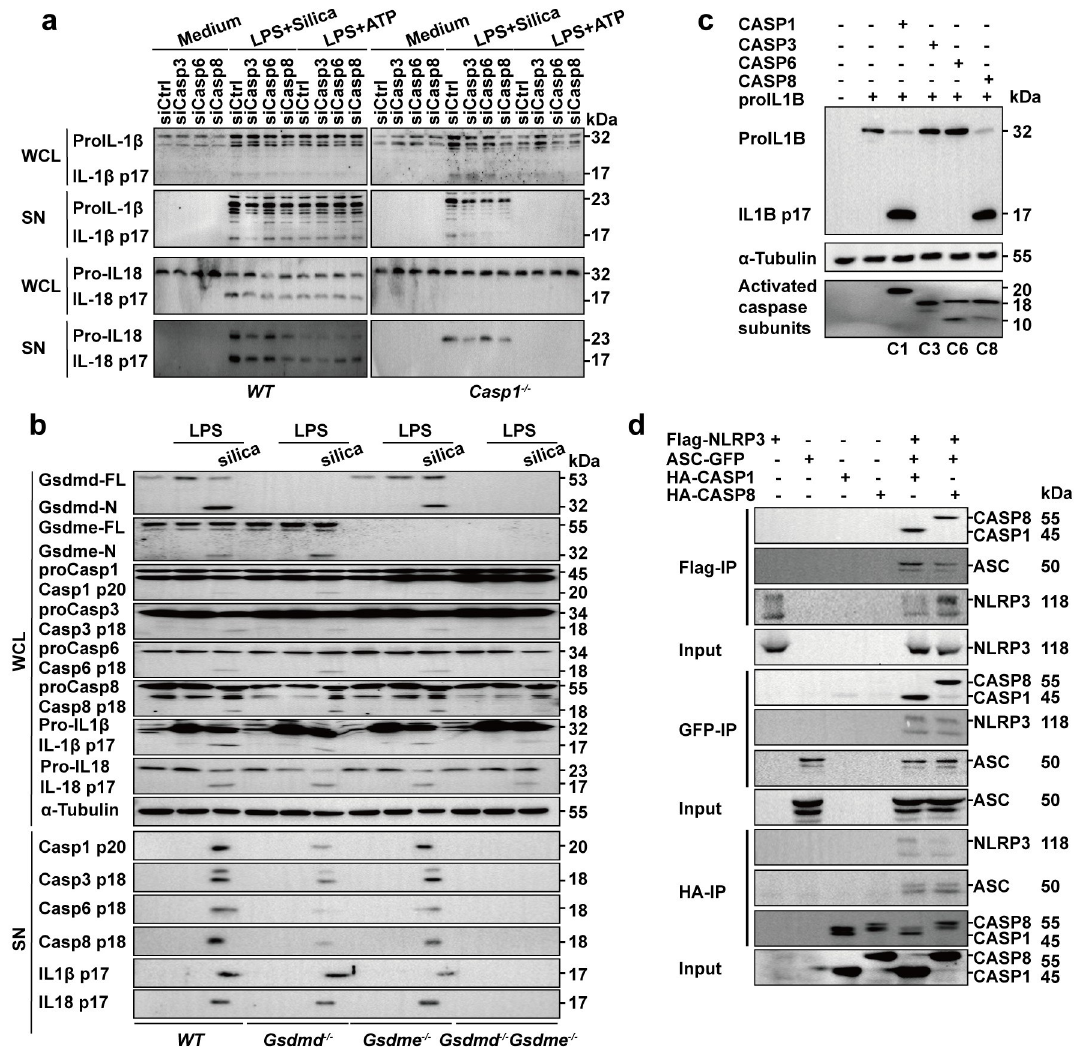
Fig 5. Caspase-1 and Caspase-8 are both engaged in IL-1 β maturation and secretion in silicosis. a Immunoblot analysis of mature IL- 1 β and IL-18 in whole cell lysate and supernatant of WT and Caspase-1 -/- BMDMs. b Immunoblot analysis of Caspase-1, Caspase-3, Caspase-6, Caspase-8 IL-1 β and IL-18 activation and release in whole cell lysate and supernatant of WT , Gsdmd -/- , Gsdme -/- and Gsdmd -/- Gsdme -/- BMDMs treated with silica for 2 h. c Recombinant proIL1B is directly cleaved by CASP1 and CASP8. d Co- immunoprecipitation analysis of the interaction of NLRP3, ASC and CASP1 or